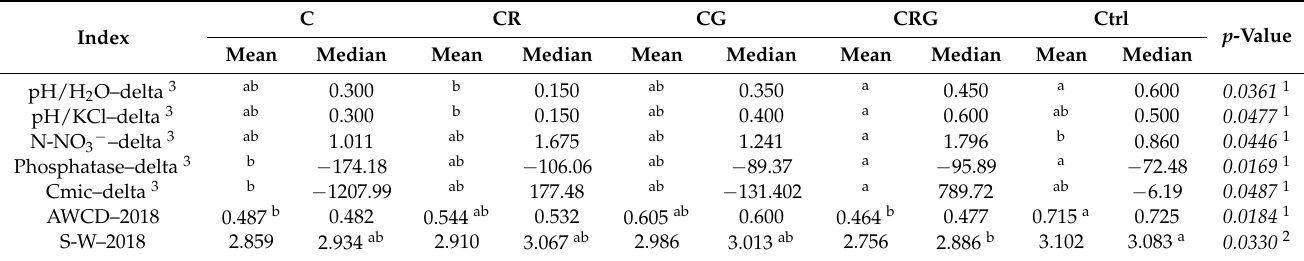
Table 2. Effect of the treatments on the differences in the soil properties between 2018 and 2017. ANOVA or Kruskal–Wallis tests were used, followed by multiple comparison tests (indices are shown in the mean and median